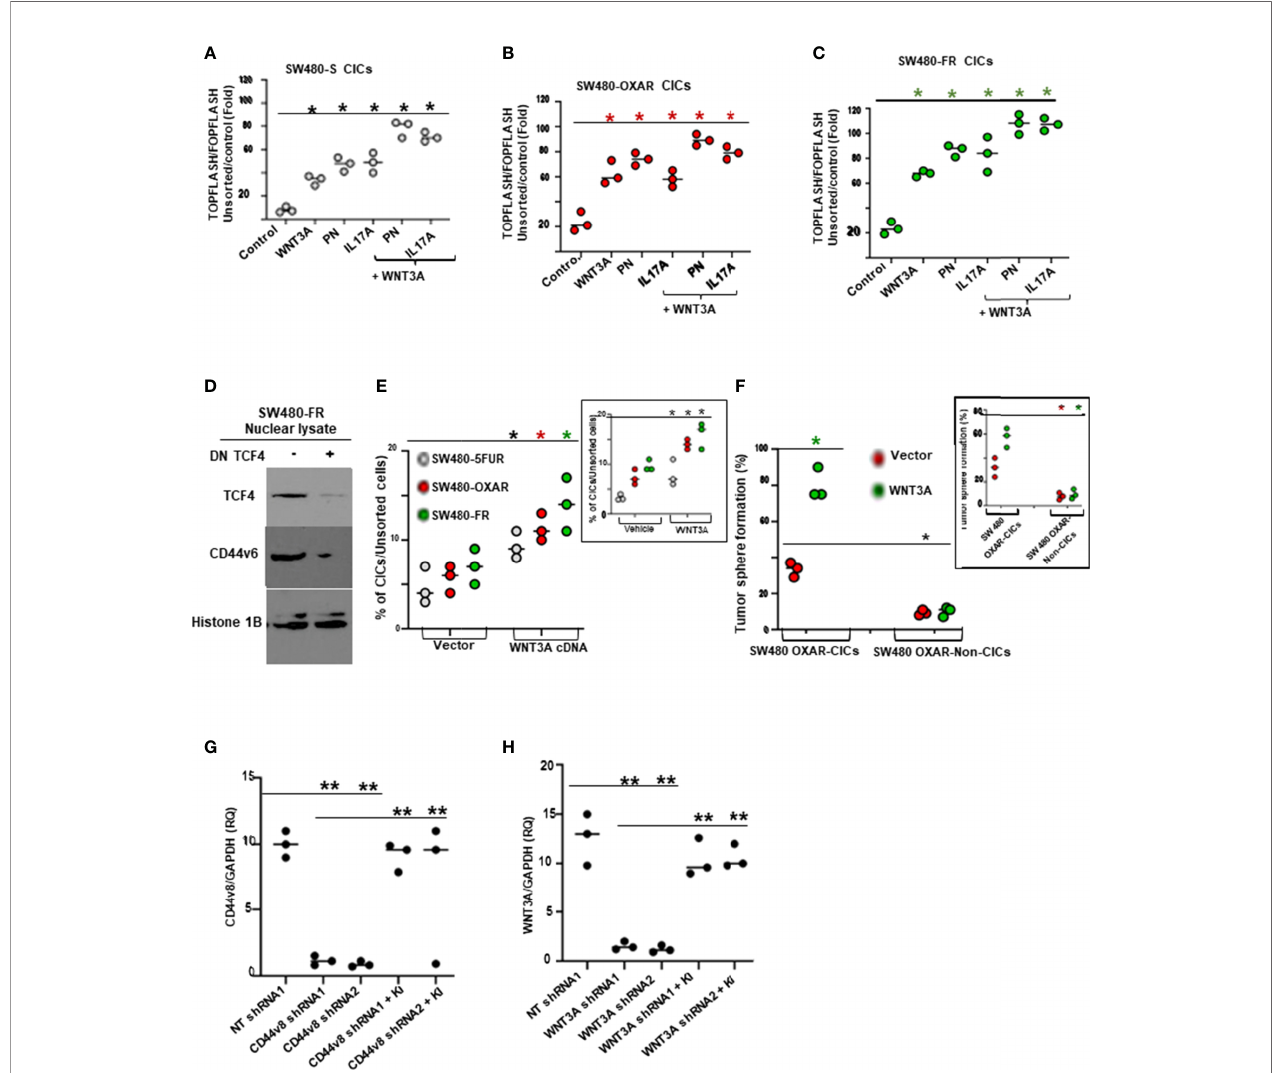
FIGURE 6 | FOLFOXinduces b-catenin/TCF4luciferase activity andtumorsphere formation in CICs stimulated byPN and/or IL17A, and TCF4 regulates CD44v6 expression. (A – C) , WNT reporter (TOPFLASH/FOPFLASH) activities were determined in SW480-S (H) , SW480-OXAR (I) and SW480-FR (J) CICs inresponse to culturing with vehicle(Control), orwith PN, or IL17A orWNT3A alone (20 ng/ml), or incombination PN + WNT3A or IL17A + WNT3A. (D) , Dominant negative TCF4 mediateddown regulation of TCF4inhibits CD44v6 expression innuclear lysates of SW480-FR SQ tumorcells. (E) , Flow cytometry analyses of percent enrichment ofCICs are shownfor unsorted cells from SW480-5FUR/SQ, SW480-OXAR/SQ andSW480-FR/SQ cells overexpressing WNT3A orvector control. (F) , Percentages of colon tumor sphere formation were measured in a sphere-formation assay for CICs andNon-CICs in SW480-OXAR SQ tumorcells overexpressingWNT3A orvector control. (G,H) , The effects of shRNA-mediatedknockdown of CD44v8and WNT3A using speci fi c shRNAs in SW480-FRcells onthe expressionsof CD44v8mRNA andWNT3A mRNA, as determined byreal-time PCR (at 24 h;RQ, relative quanti fi cation)were done bythe indicated shRNA mediated knockdown andthe correspondingknock-in (KI) gene transfections as describedin Methods. Target mRNAs were analyzed byQRT-PCR analysis (GAPDH, internal control). Data in A – C,E – H , represent means± SD;n = 3 – 6 independent replicates in three independent experiments; (A – C) , *p < 0.05 was consideredsigni fi cant, stimulation ofTOPFLASH/FOPFLASH activities in treatment groups compared to control groups. (D) , Western blot data are representative of three experiments. (E) , *p < 0.05 was considered signi fi cant, stimulation of% of CICs byWNT3A over expression or exogenously added WNT3A group (inset) compared to respective control groups. , (F) , *p< 0.05 was considered signi fi cant, stimulation of tumor sphere formation in WNT3A over expression or exogenouslyaddedWNT3A group (inset) compared to respectivecontrol groups. (G, H) , **p < 0.01 was considered signi fi cant, Fold inhibition of CD44v8andWNT3A mRNA inshRNAs overexpressinggroups compared to corresponding NT shRNA groups; Fold restoration of CD44v8and WNT3A mRNA incorresponding shRNA + Knock-in (KI) groups comparedto corresponding shRNA groups. Student ’ s t-test was used to assess the signi fi